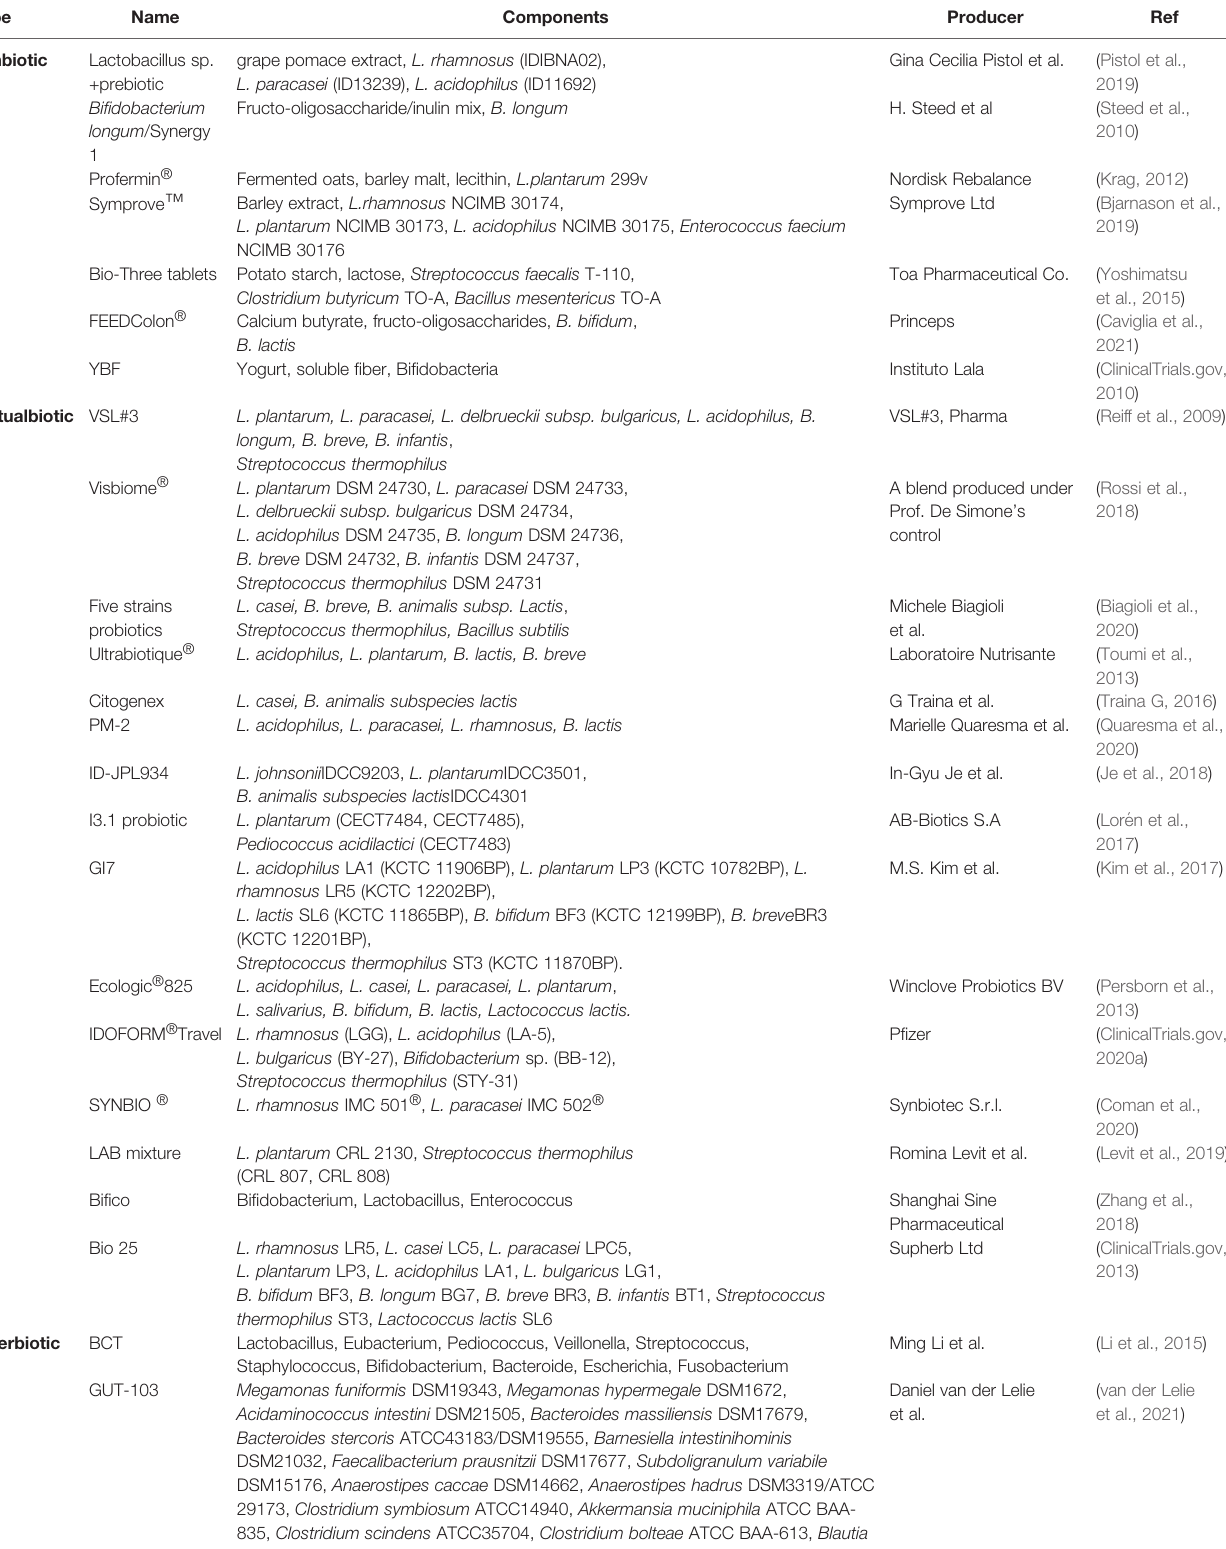
TABLE 2 | Four categories of arti fi cial consortium transplantation